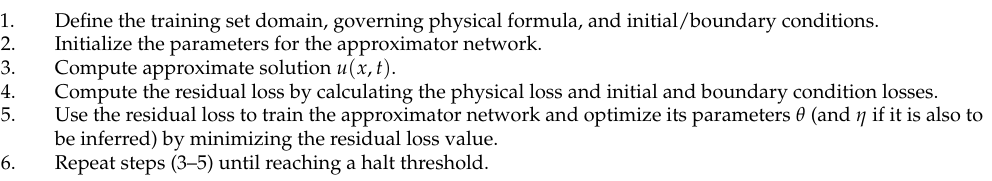
Algorithm 1 Physics-informed neural network for solving the wave